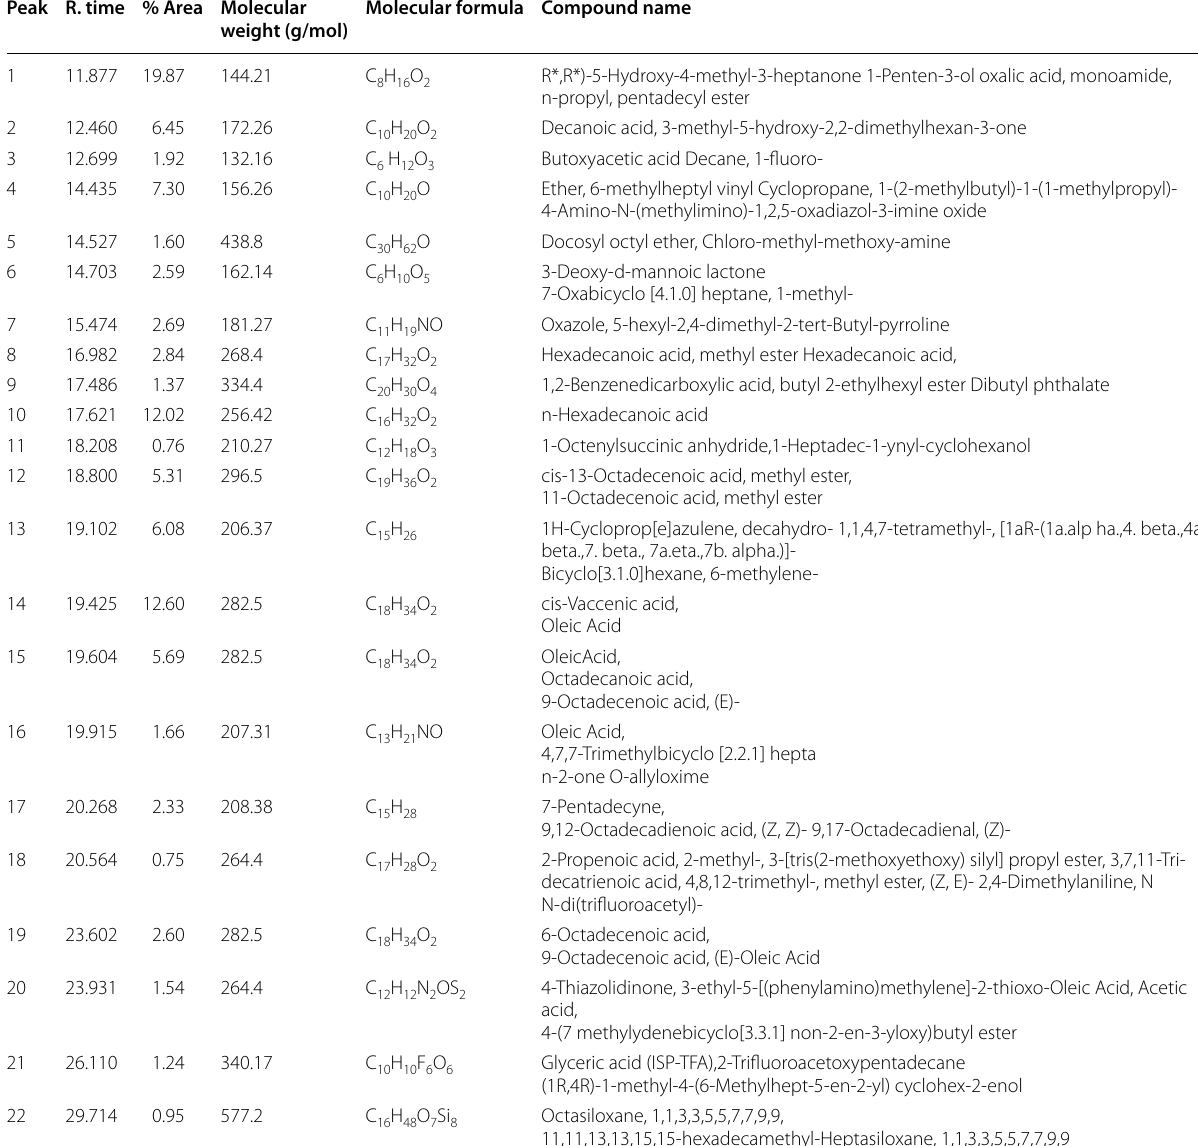
Table 2 Phyto-constituents of METS as detected by gas chromatography–mass spectrometry analysis Peak R. time % Area Molecular Molecular formula Compound weight (g/mol)